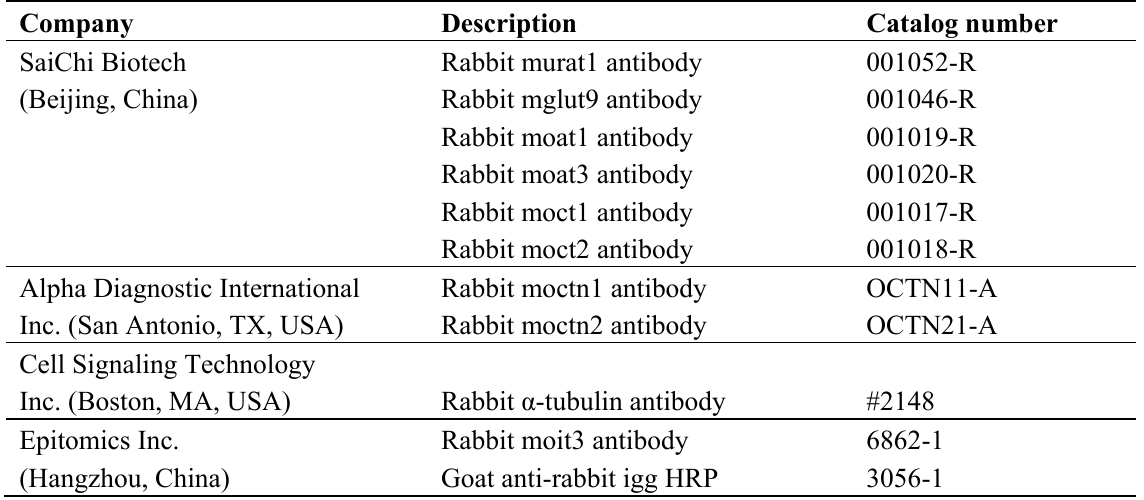
Table 3. Antibodies used for western blot